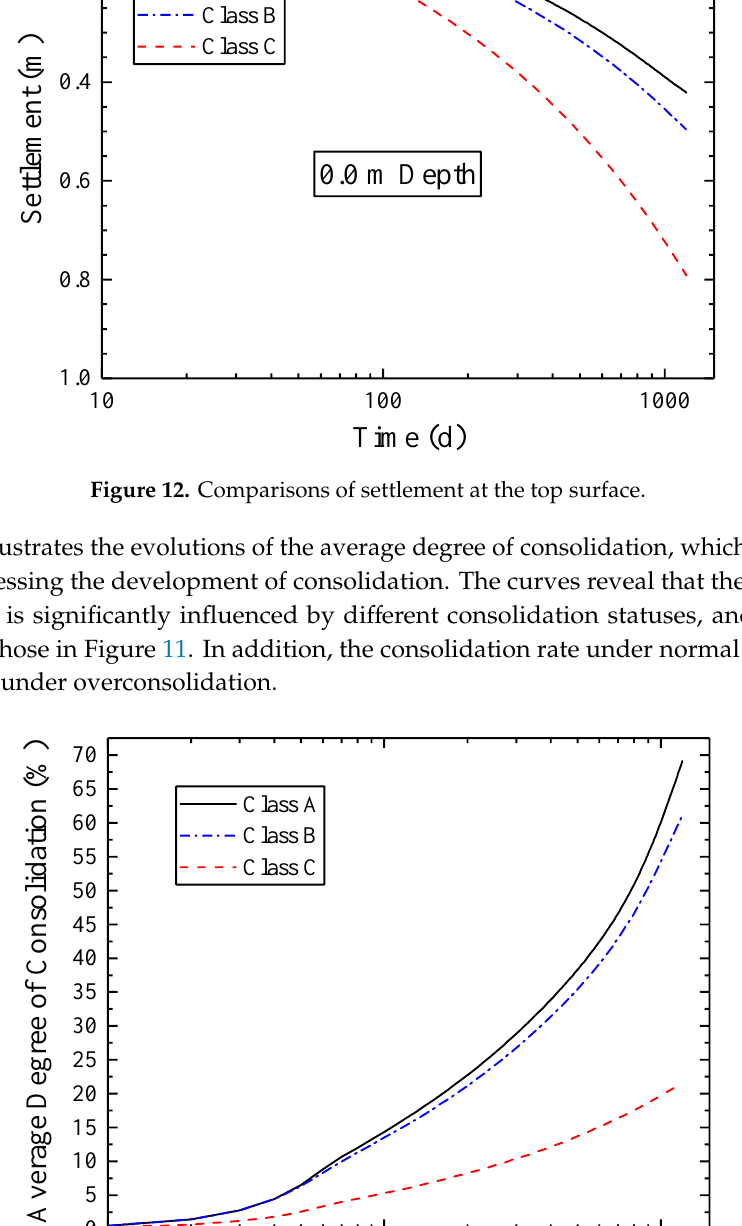
Figure 13. Comparisons of average degree of consolidation.